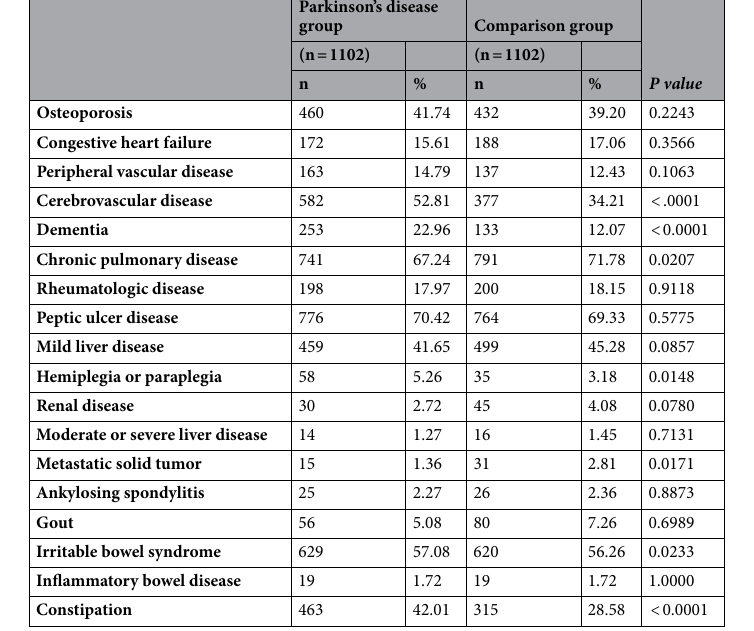
Table 1. Characteristics of study participants.